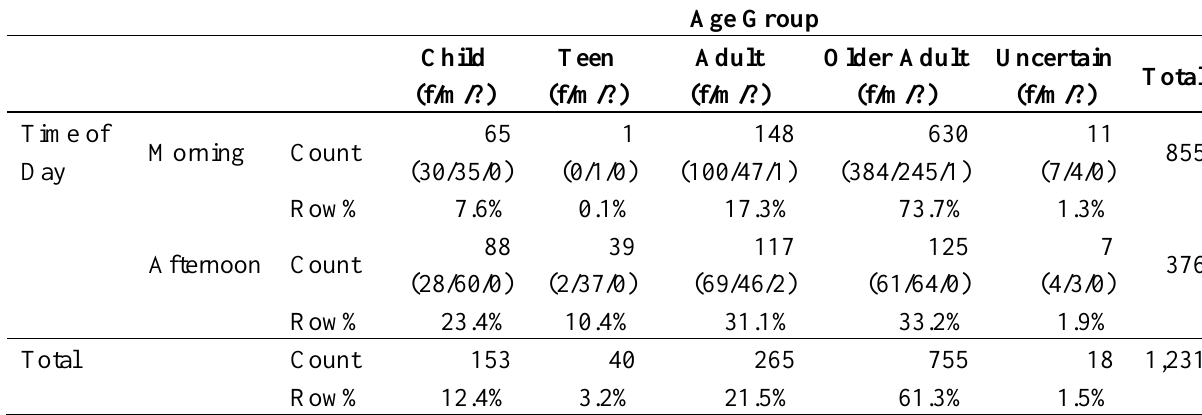
Table 4. Green space usage by age group, gender, and time of